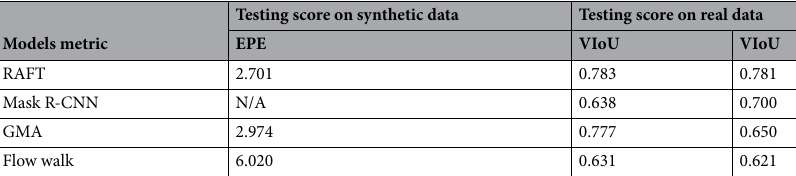
Table 1. Scores from testing for each model with corresponding score metrics, endpoint error (EPE) and volumetric IoU (VIoU). Lower EPE and higher VIoU are better. Among four models, RAFT performs best with the lowest EPE and highest VIoU. Mask R-CNN misses EPE because it is not an optical flow detection model but a mask detection model. EPE for real data is not presented because the real data does not have ground-truth optical flow